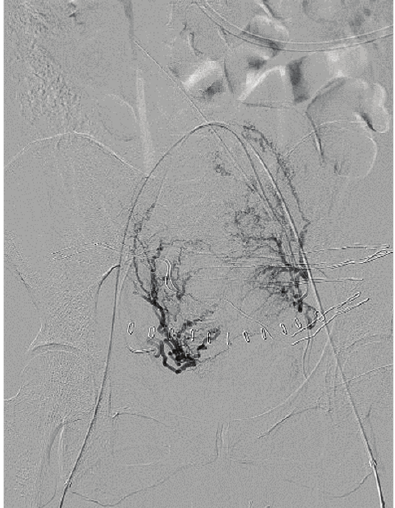
Figure 2: Arteriography of both uterine arteries before emboliza-